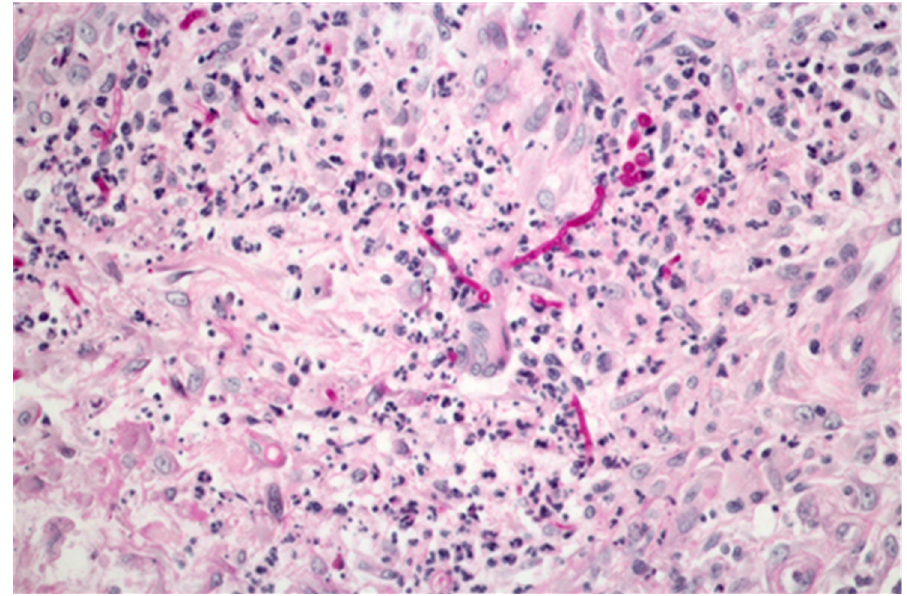
Figure 2. Skin ‐ biopsy specimen from an organ transplant patient with deep dermatophytosis (PAS, 400× ) showing hyphae in the dermis.